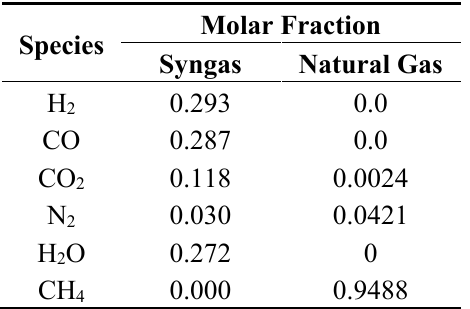
Table 2. Syngas and natural gas